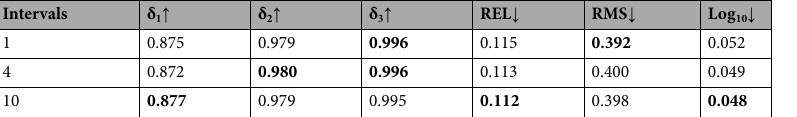
Table 8. Quantitative comparison of different numbers of depth intervals. The better results are shown in bold.